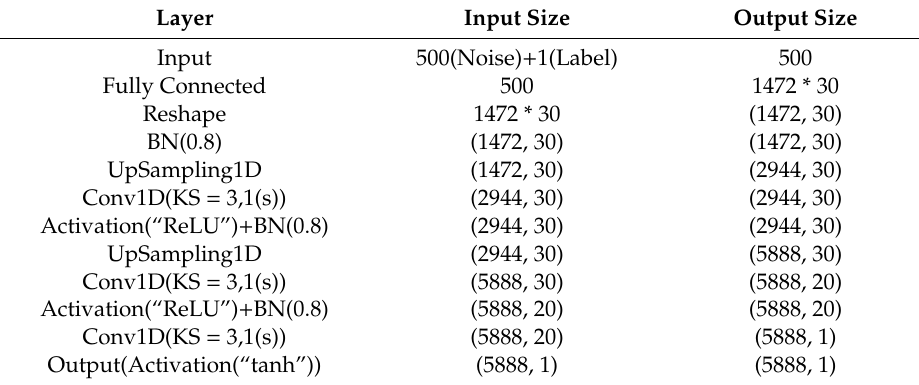
Table 1. The structure of generator in unidimensional